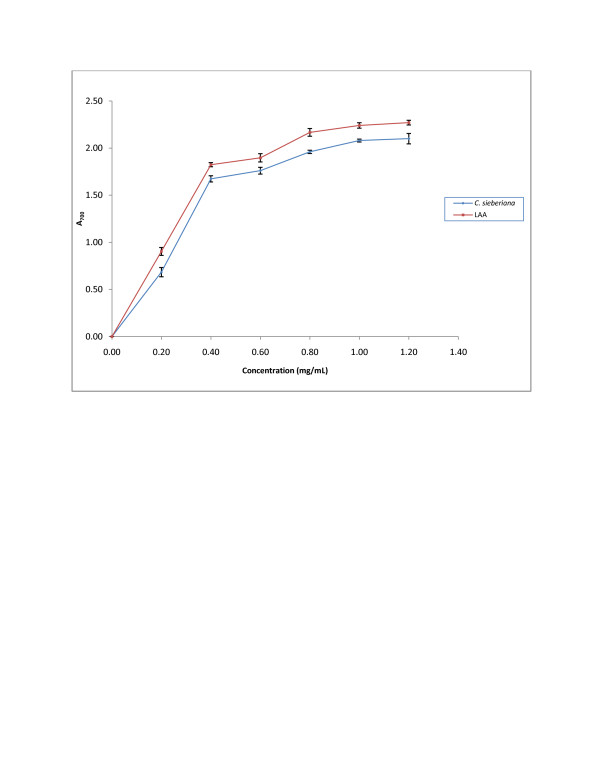
Reducing power ofC. sieberianaroots bark extract. L-ascorbic acid (LAA) was used as a reference compound. Results are means ± SEM of n = 3.